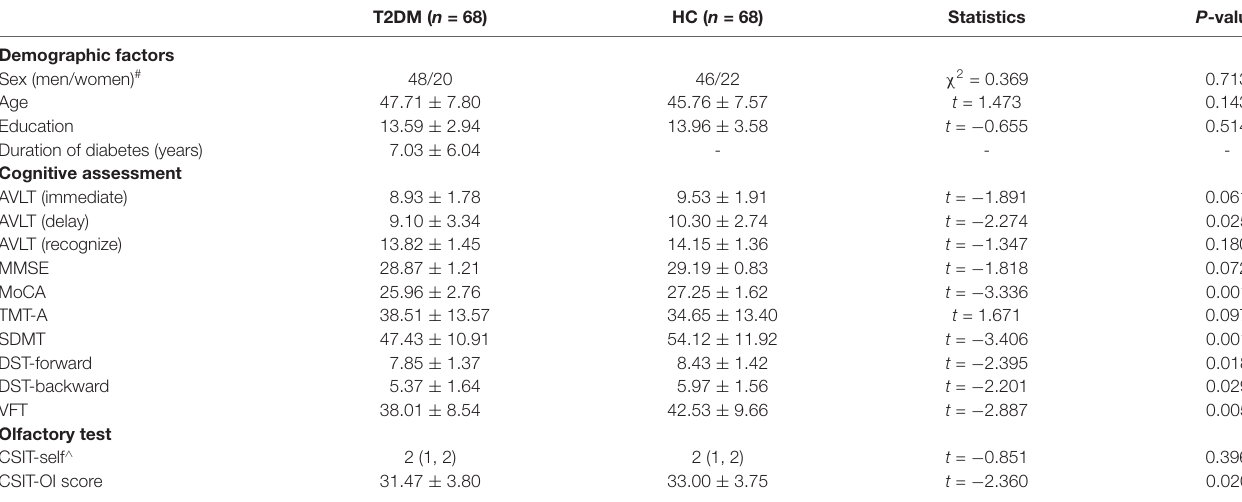
TABLE 1 | Demographic and clinical variables, cognitive assessment scores, and olfactory test scores. T2DM ( n =